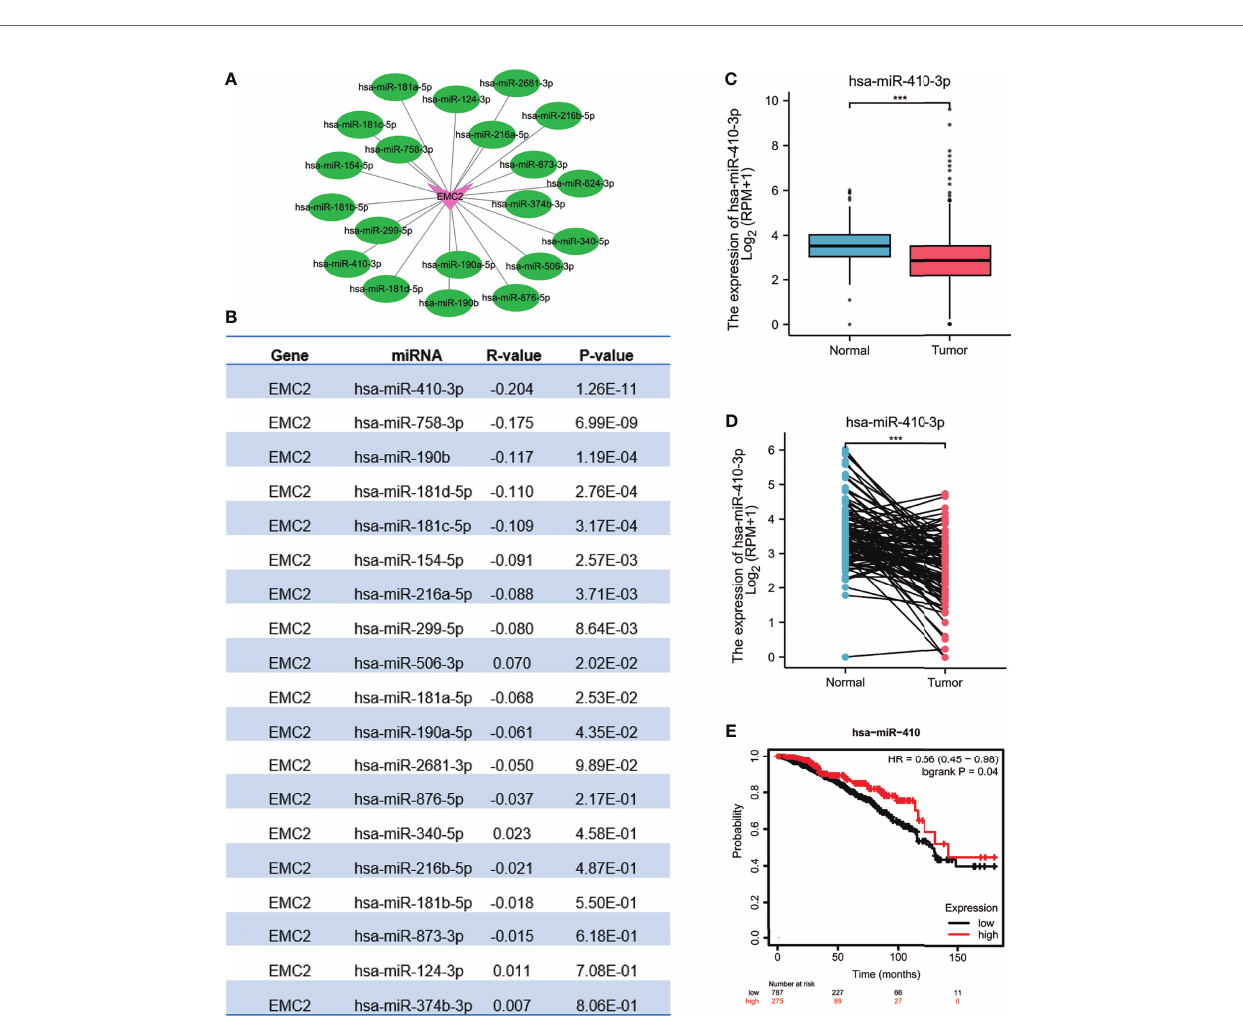
FIGURE 5 | Identi fi cation of hsa-miR-410-3p as a potential upstream miRNA regulating EMC2 expression in BRCA. ( A ) The miRNA-EMC2 regulatory network established using Cytoscape software. ( B ) The expression correlation between predicted miRNAs and EMC2 in BRCA analyzed using starBase database. ( C ) hsa-miR- 410-3p expression in breast cancer based on TCGA (cancer tissue) and GTEx (normal tissues of unpaired samples) databases. ( D ) hsa-miR-410-3p expression in breast cancer based on paired cancer samples obtained from TCGA. ( E ) The prognostic value of hsa-miR-410-3p in BRCA assessed by Kaplan-Meier plotter. ***P <